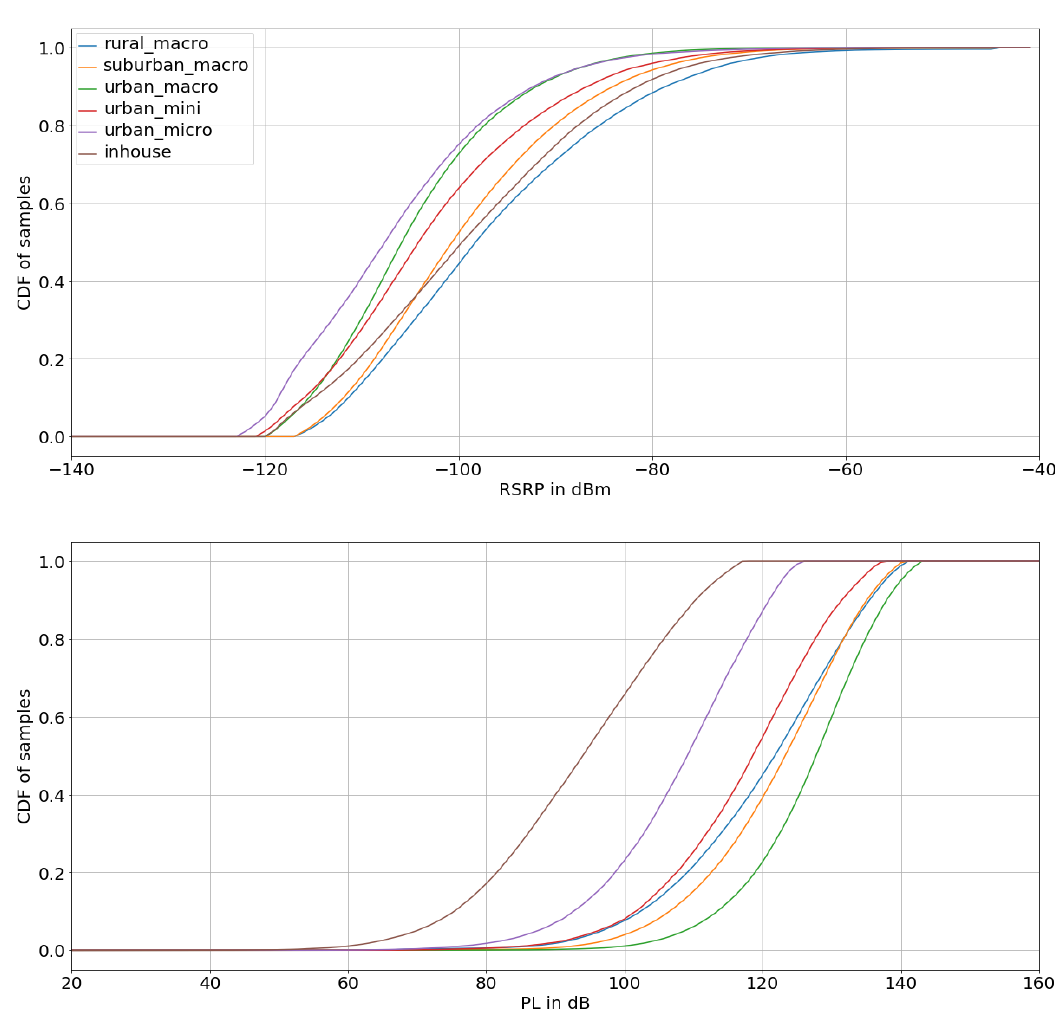
Figure 1. Cumulative distribution functions of the categorized path loss ( top ) and reference signal received power ( bottom ) measurements in a Swiss LTE